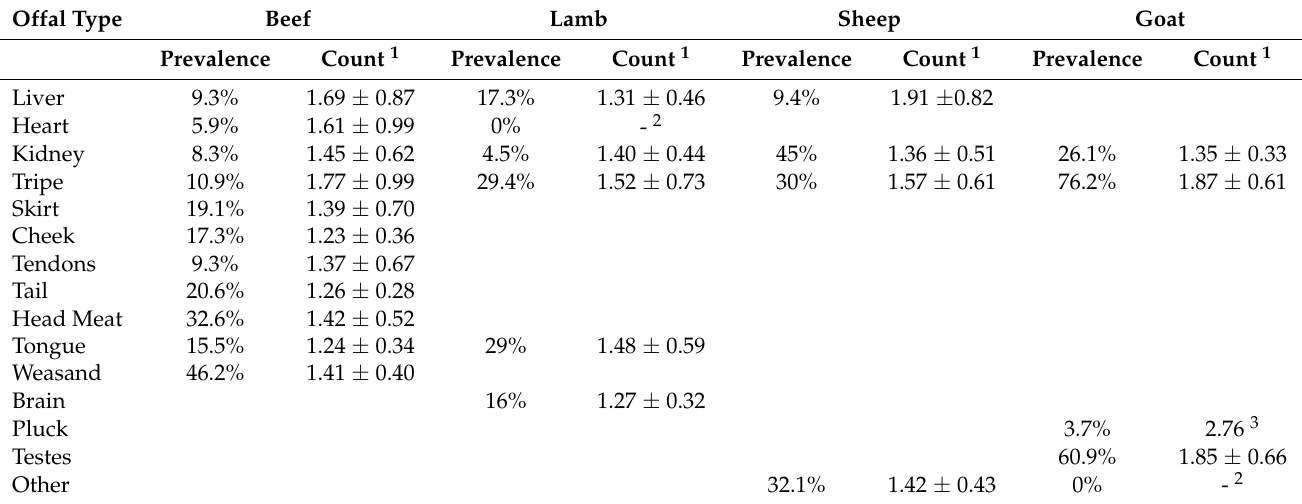
Table 4. Faecal indicators (average log 10 E. coli prevalence and count) for different offal types. For some sheep and goat offal types, only a small number of samples was analysed and combined under the heading ‘Other’ (brain, heart, skirt, and tongue for sheep and heart, liver, and spleen for goat). Lung and pluck data for goat were combined under the category ‘pluck’.